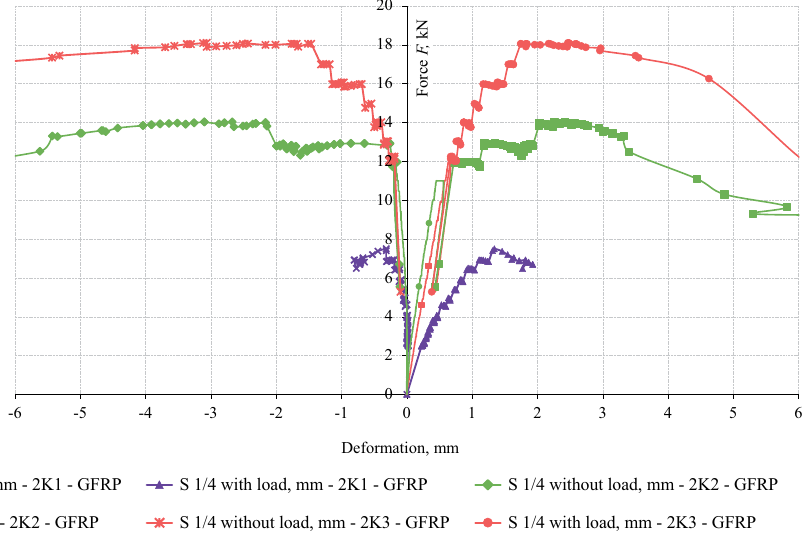
Figure 5. Comparison of deformations in vaults loaded at quarter span and strengthened with glass fibre reinforced polymer reinforcement